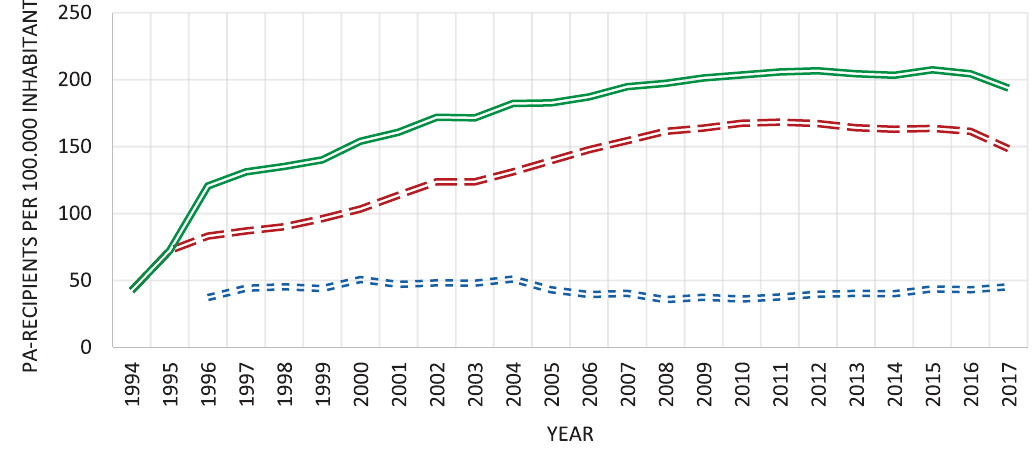
Figure 1. Relative number of PA-recipients, 1994–2017. Sources: own calculations based on Statistics Sweden (2018), SSIA (2017a) and NBHW (2017a); data from SSIA retrieved from Independent Living Institute